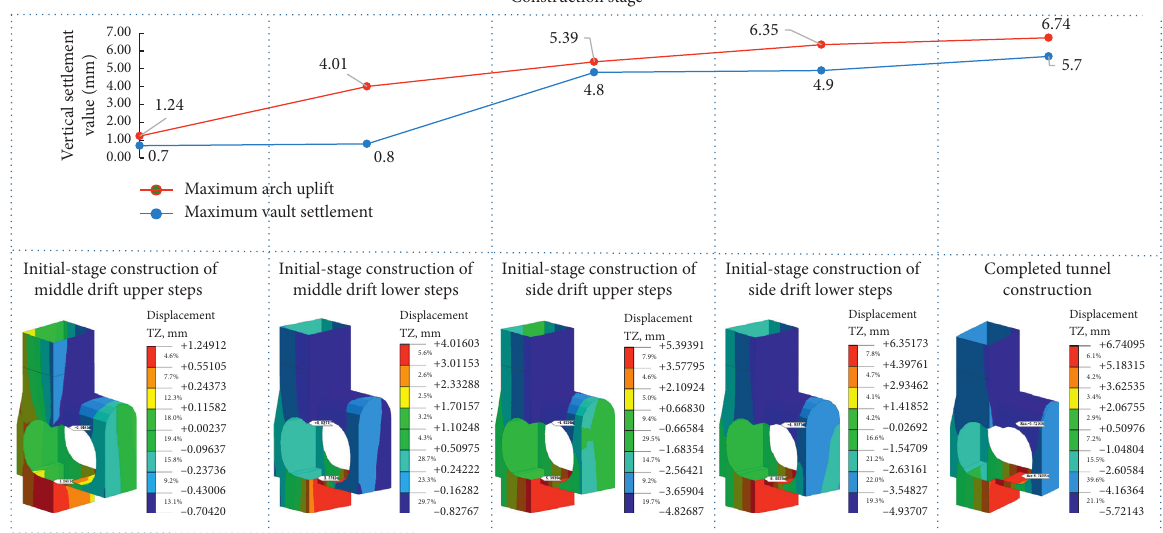
Figure 12: Vertical deformation cloud of supporting